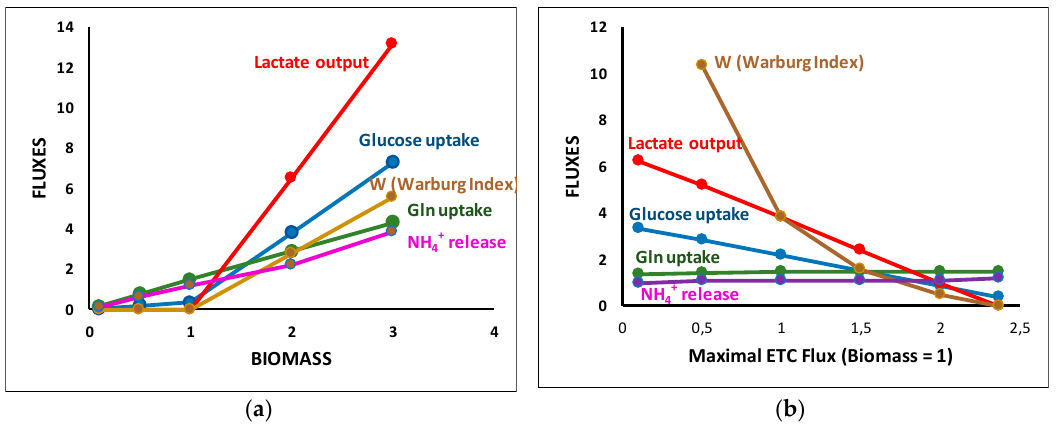
Figure 10. The Warburg effect. ( a ) Increase in biomass at constant respiratory chain content (ensuring maximum biomass equal to 1). ( b ) Decrease in respiratory rate from the sufficient value (2.374) to insure ATP synthesis and NADHc reoxidation. W is an index measuring the Warburg effect defined in [55] as the ratio of lactate release over respiratory chain (RC34) activity.